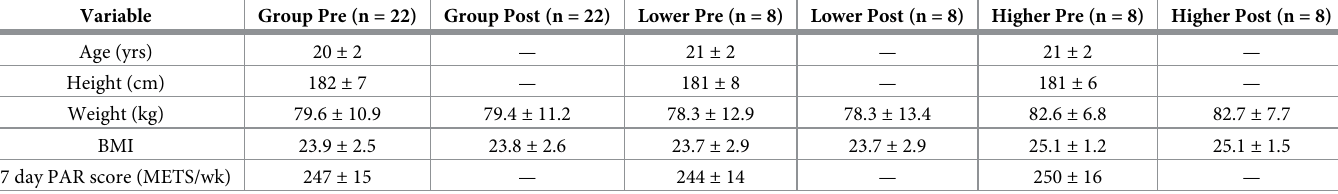
Table 1. Anthropometric measures.